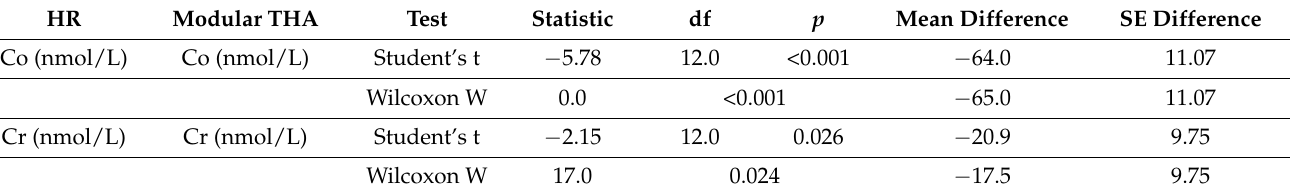
Table 5. Comparison of Metal Ions Levels.